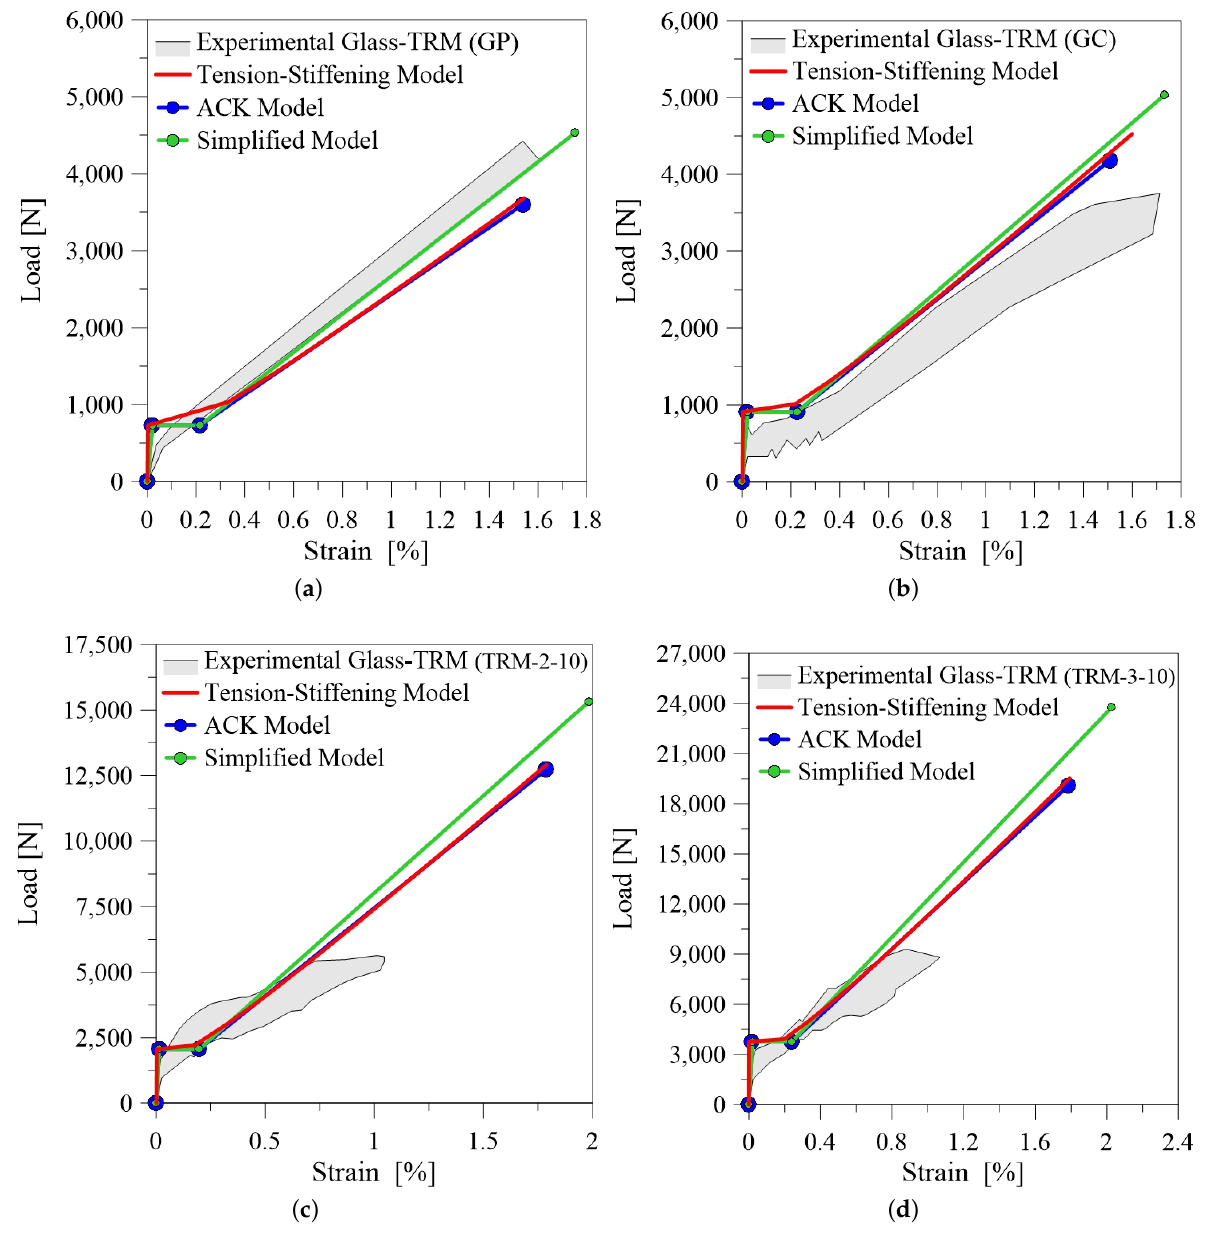
Figure 8. Comparison between experimental and analytical curves for glass-TRM: ( a ) reference Bellini et al. [19] (GP); ( b ) reference Bellini et al. [19] (GC); ( c ) reference Bramato et al. [20] (3L-5); ( d ) reference Bramato et al. [20]